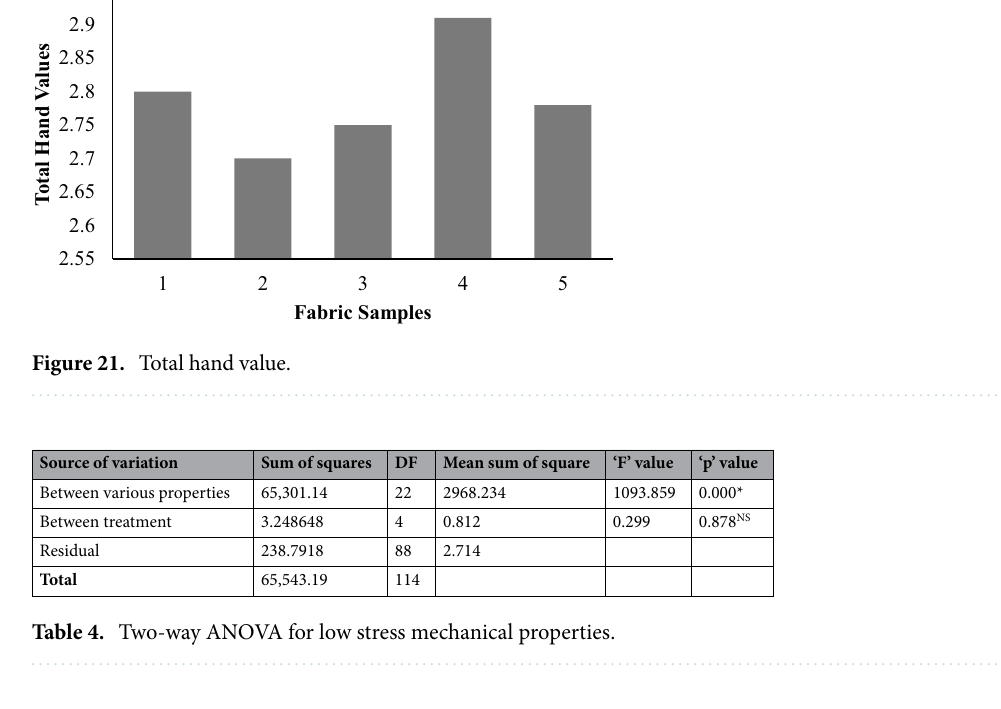
Table 4. Two-way ANOVA for low stress mechanical properties.